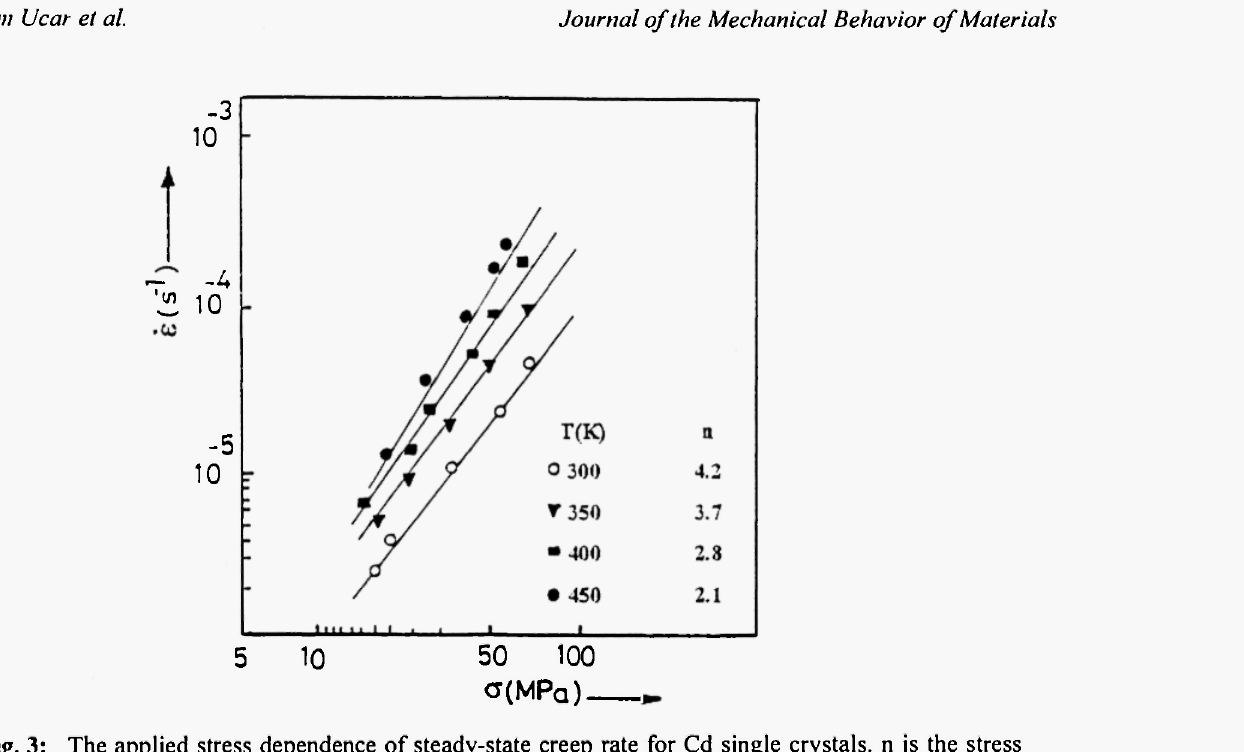
Fig. 3: The applied stress dependence of steady-state creep rate for Cd single crystals, η is the stress exponent.